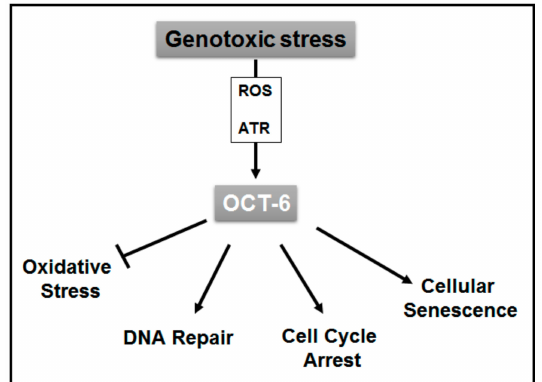
Figure 6. Proposed model for the role of Oct-6 in the regulation of cellular response to genotoxic stress. Genotoxic stress induces Oct-6 expression in cancer cells through ROS and ATR-dependent mechanisms. This transcription factor exerts a protective role against genotoxicity through the regulation of critical cellular processes triggered by DNA damage-mediated stress response. Oct-6 inhibits ROS production, decreases DNA damage, and promotes cell cycle arrest as well as cellular